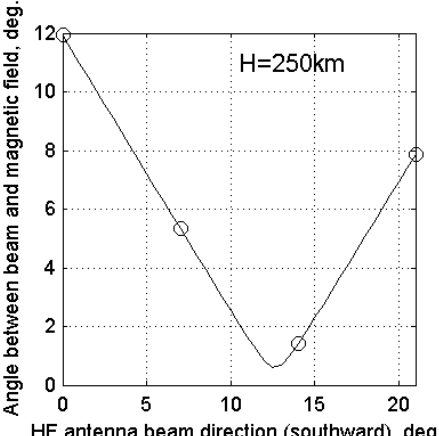
Fig. 2. Antenna layout in the SEE experiment.